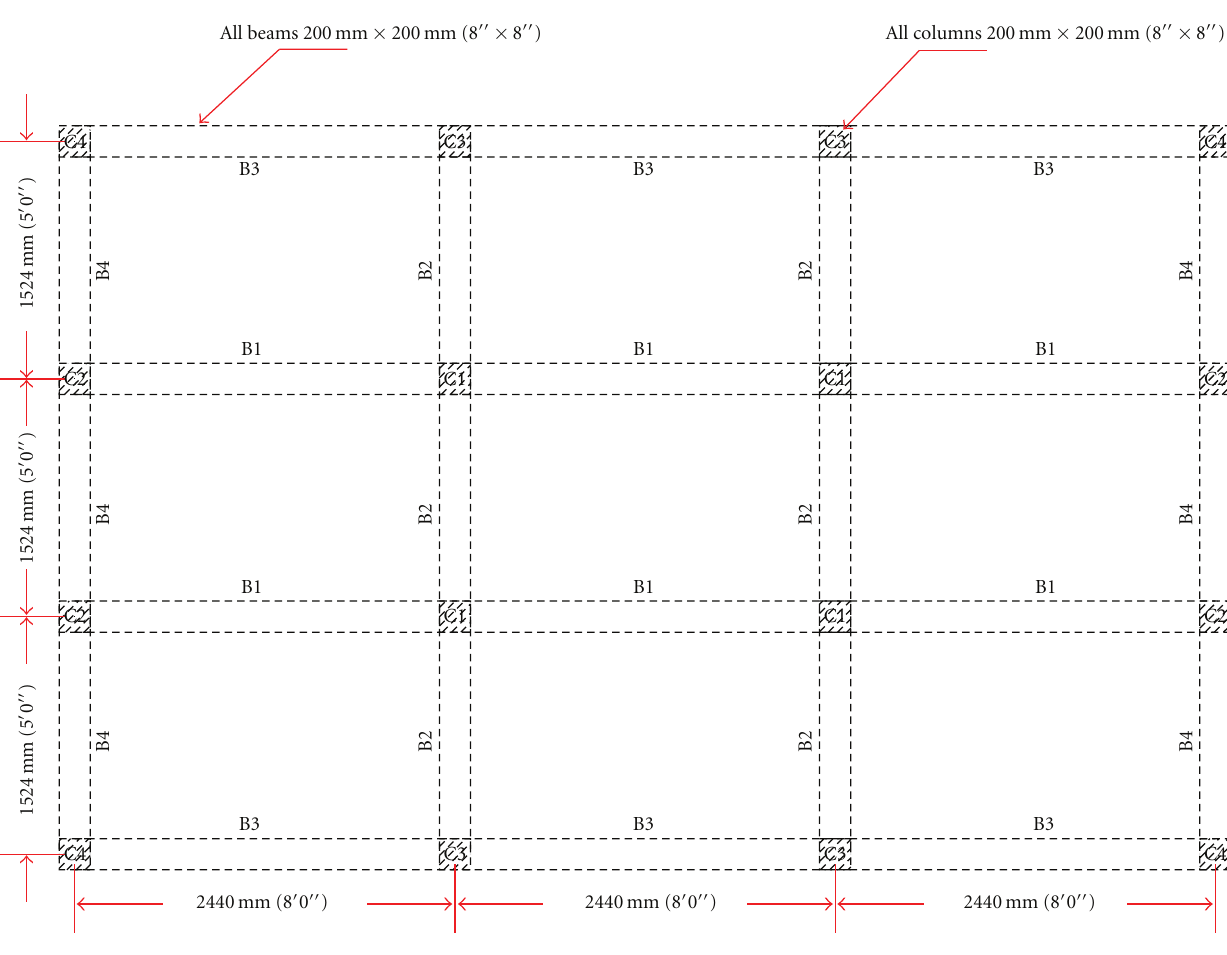
Figure 5: Plan of the 1/3rd scaled model.